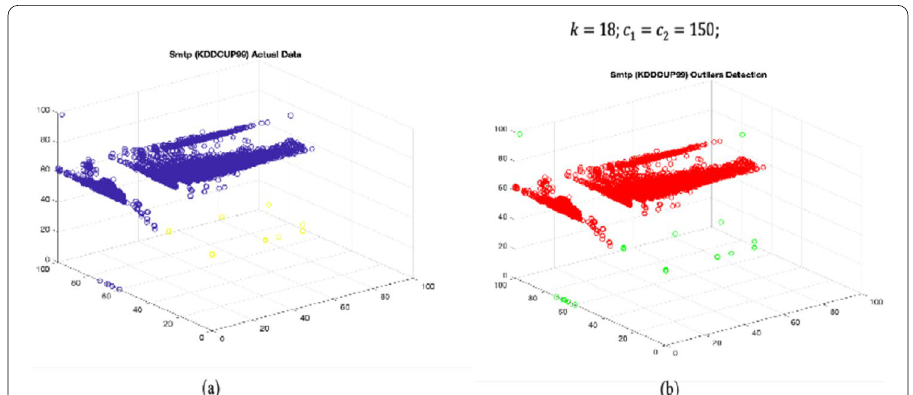
Fig. 12 a Ground truth of the real data used to evaluate the proposed methods, blue data points are inliers and yellow are the outliers. b Results achieved using the boxplot with extreme values proposed in Eq. 6. Red points are inliers and green are outliers